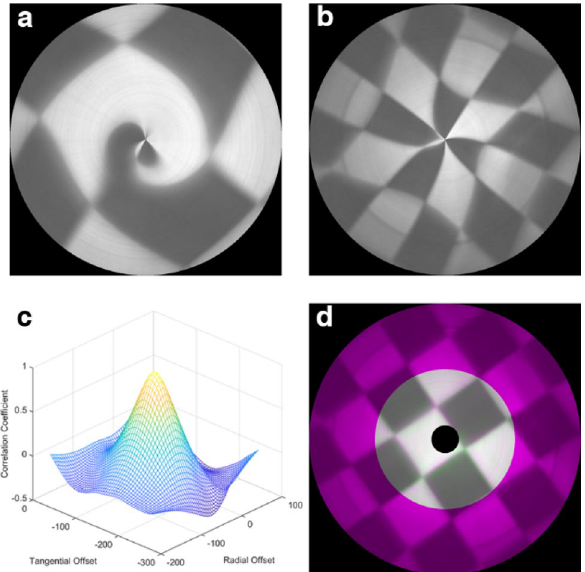
Figure 3. ( a ) Reconstructed image by short scan line; ( b ) reconstructed image by long scan line; ( c ) correlation coefficient chart; ( d ) optimum reconstructed